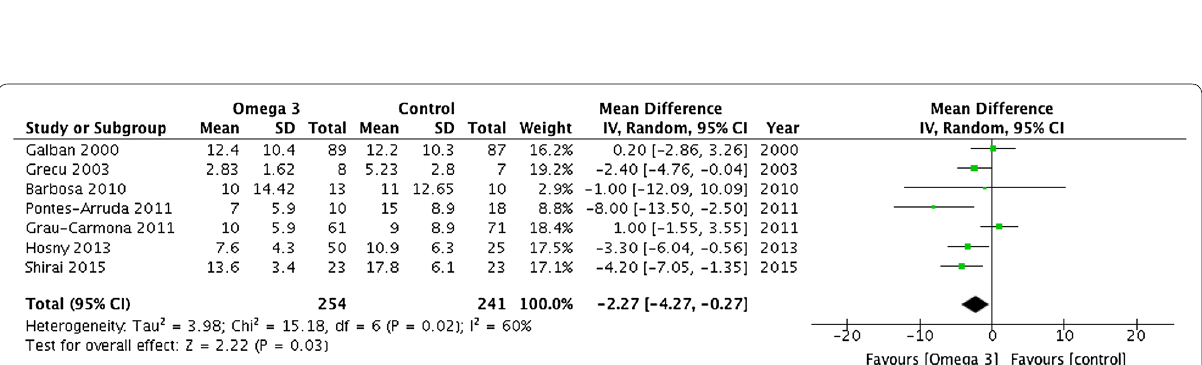
Fig. 5 Duration of mechanical ventilation outcome. Data from 7 trials ( n model. Omega-3 supplementation was associated with a significantly shorter duration of mechanical ventilation. IV inverse